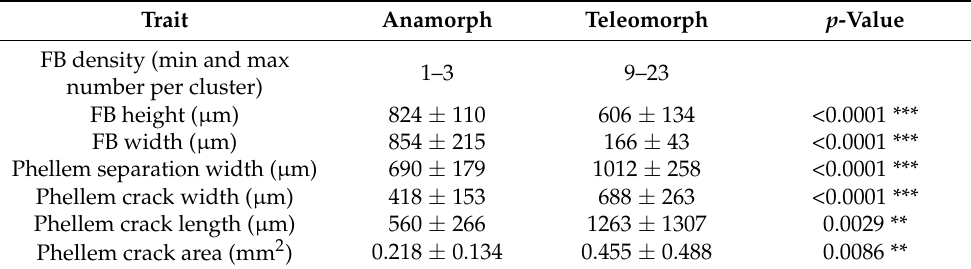
Table 1. Morphological traits of fruiting bodies (FBs) and phellem cracks. Trait Anamorph